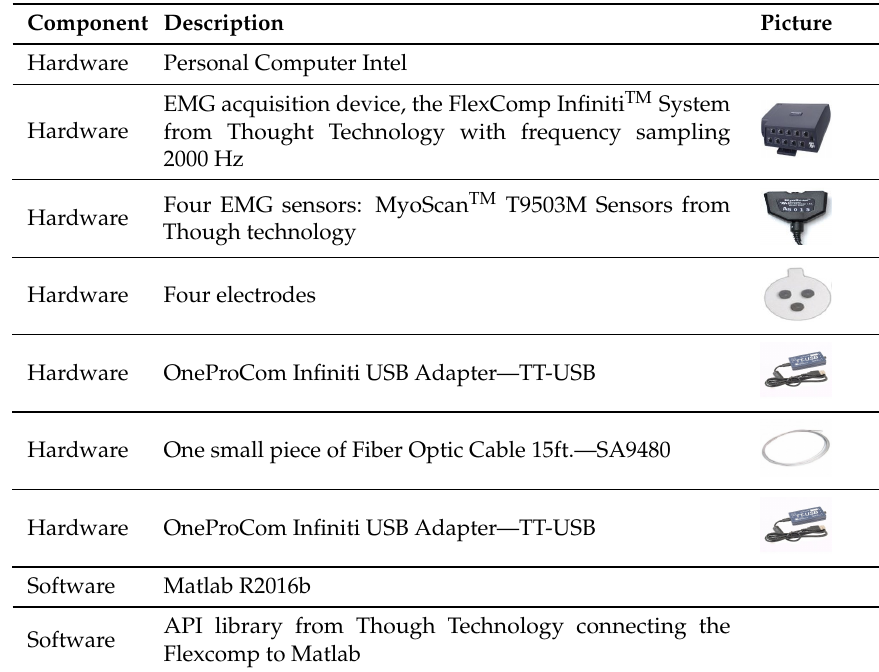
Table 1. The hardware and software needed for the off-line